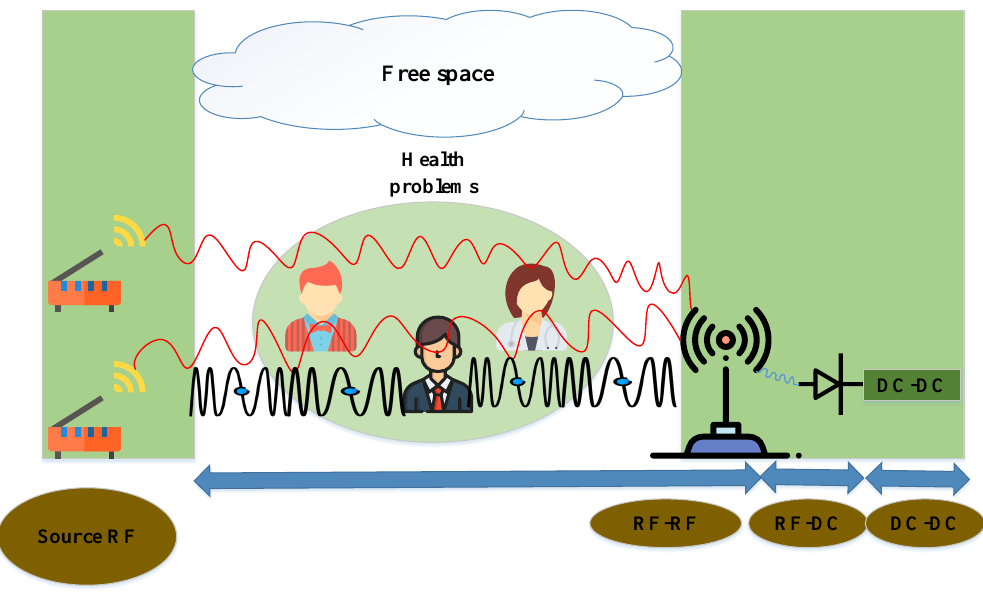
Figure 16. Challenges of wireless power